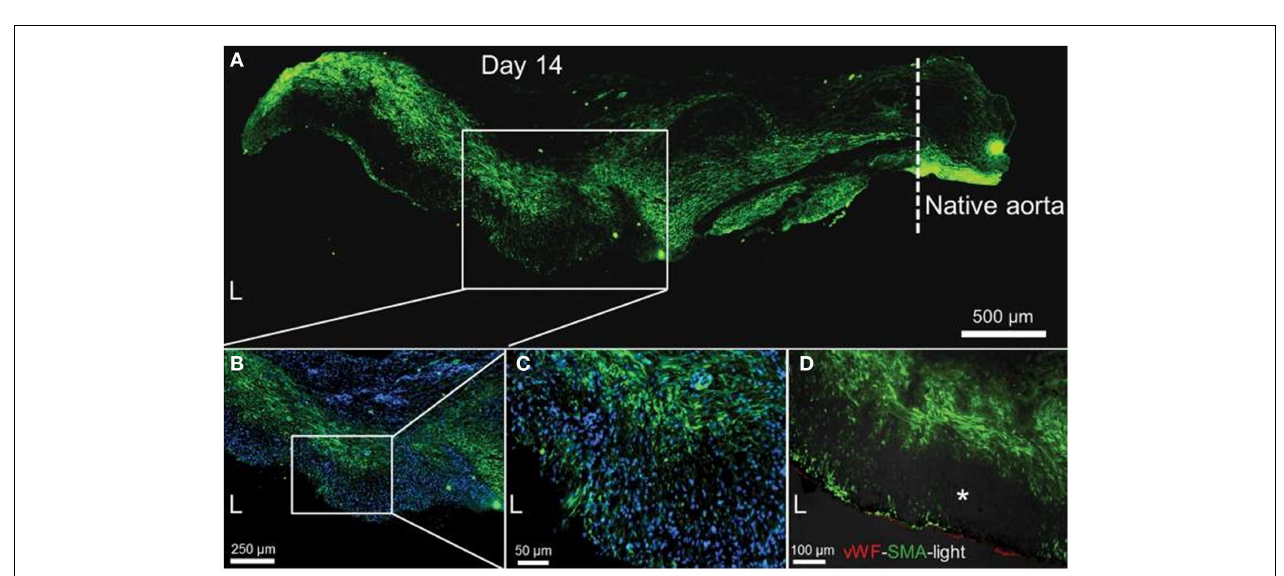
view the complicated SMC distribution (SM α A, green); scale bar, 50 µ m. (D) Distribution of endothelial cells (vWf, red) and smooth muscle cells (SM α A, green) in the graft wall. Immunofluorescence images merged with the bright-field image (darkened to not overwhelm the fluorescence images). Dark spots (*) in the bright-field image might be residual graft material; scale bar, 100 µ m. Adapted by permission from Macmillan Publishers Ltd. [Nature Medicine] (Wu et al., 2012), copyright (2012).